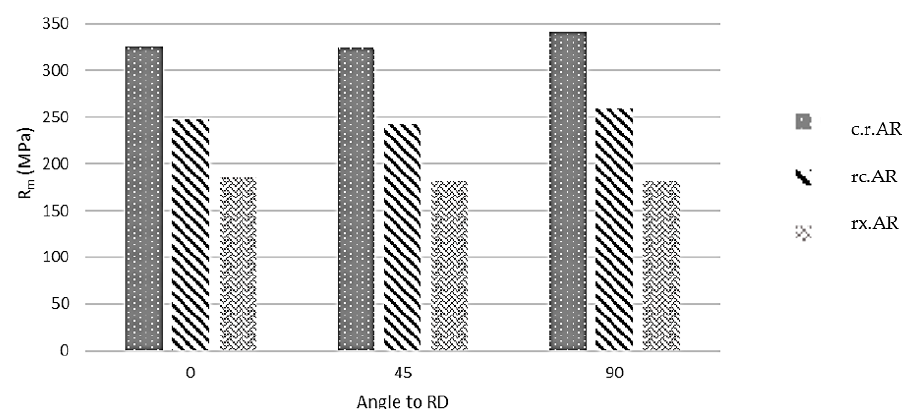
Figure 1. Tensile strength of the samples depending on their relative angle to RD. The planar anisotropy parameter ( ∆ r) is an indicator of the ability of a material to demonstrate a “non-earing” behavior (lower values are preferable) while r m , is an excellent